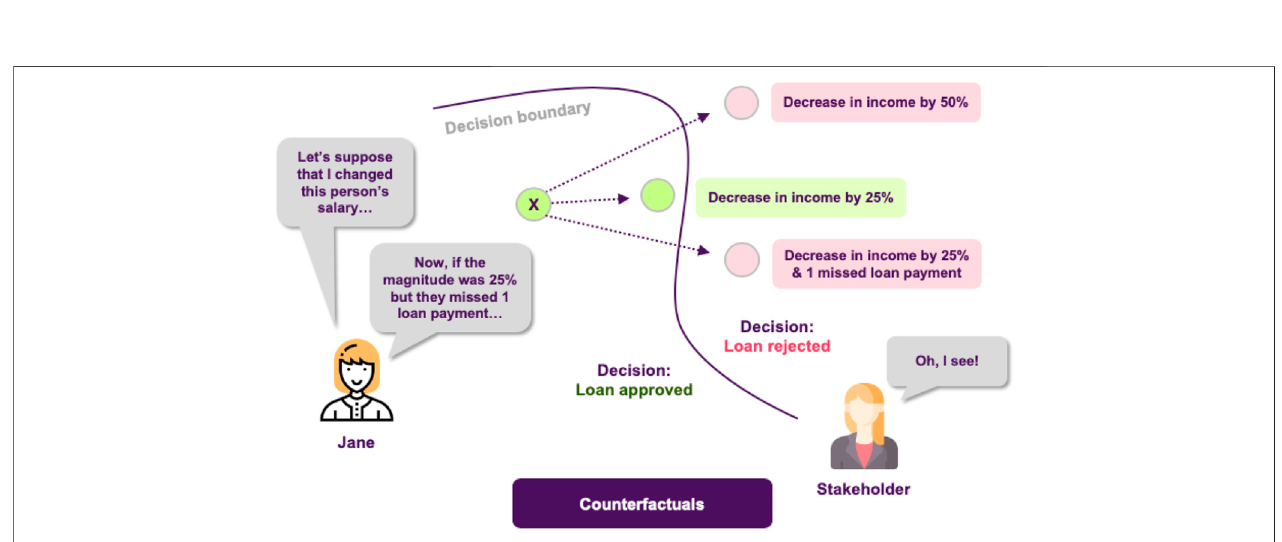
FIGURE 8 | Counterfactuals produce a hypothetical instance, representing a minimal set of changes of the original one, so the model classi fi es it in a different category.